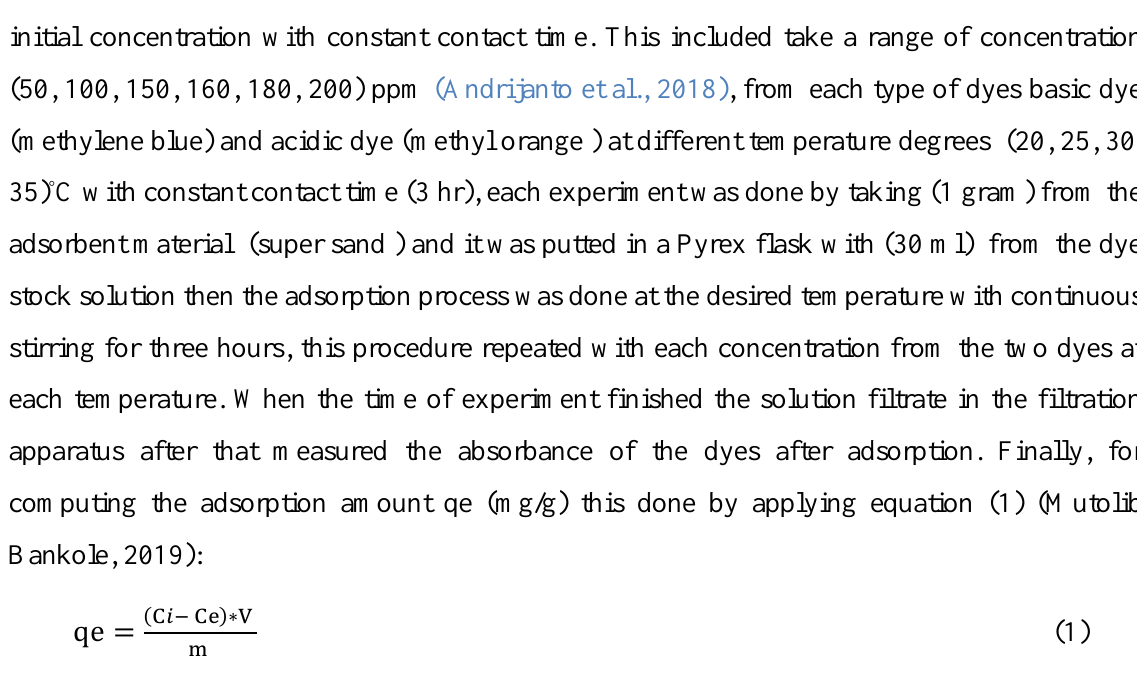
Fig. 3 . Photographic picture for the apparatus used for adsorption dyes by super